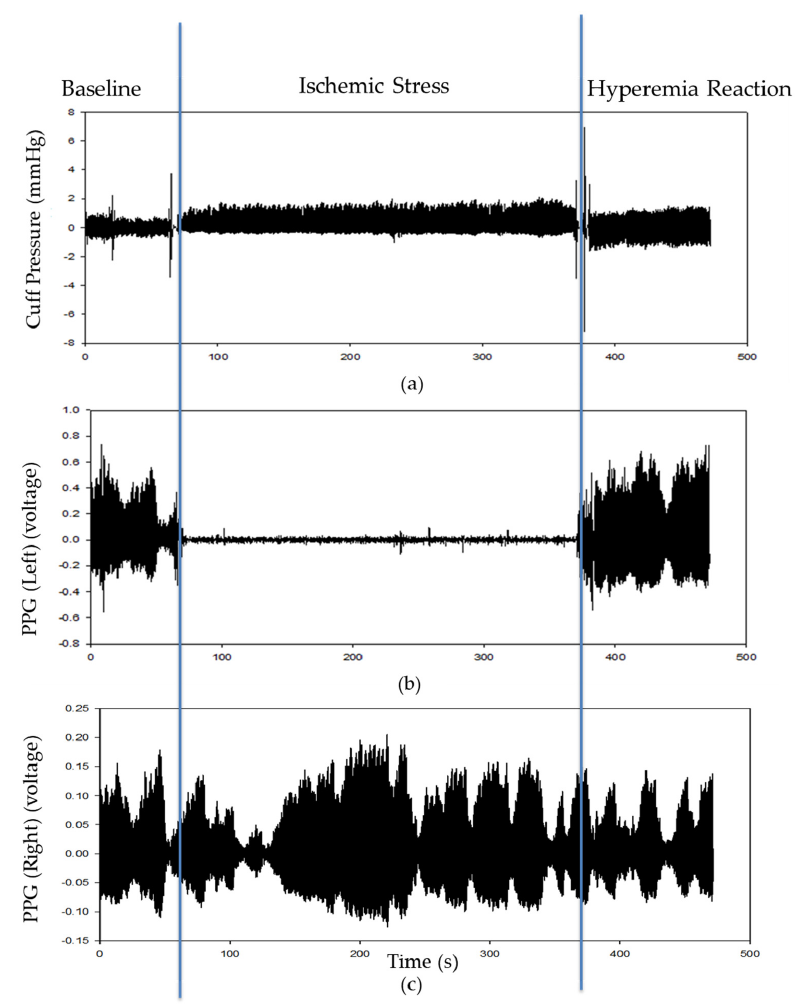
Figure 4. The cuff-pressure signal and PPG signals for subject #37 during FMD measurement, ( a ) cuff-pressure signal after passing through the digital high-pass filters, ( b ) PPG signal of left hand, PPG ( Left ), ( c ) PPG signal of right hand, PPG ( Right ).